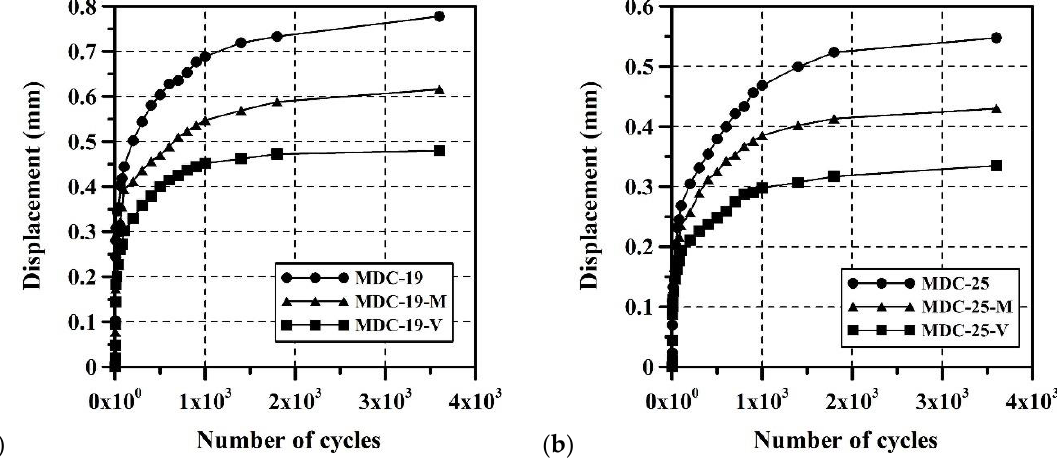
Figure 7. Permanent displacement: ( a ) MDC-19, MDC-19-M, and MDC-19-V; ( b ) MDC-25, MDC-25-M, and MDC-25-V.